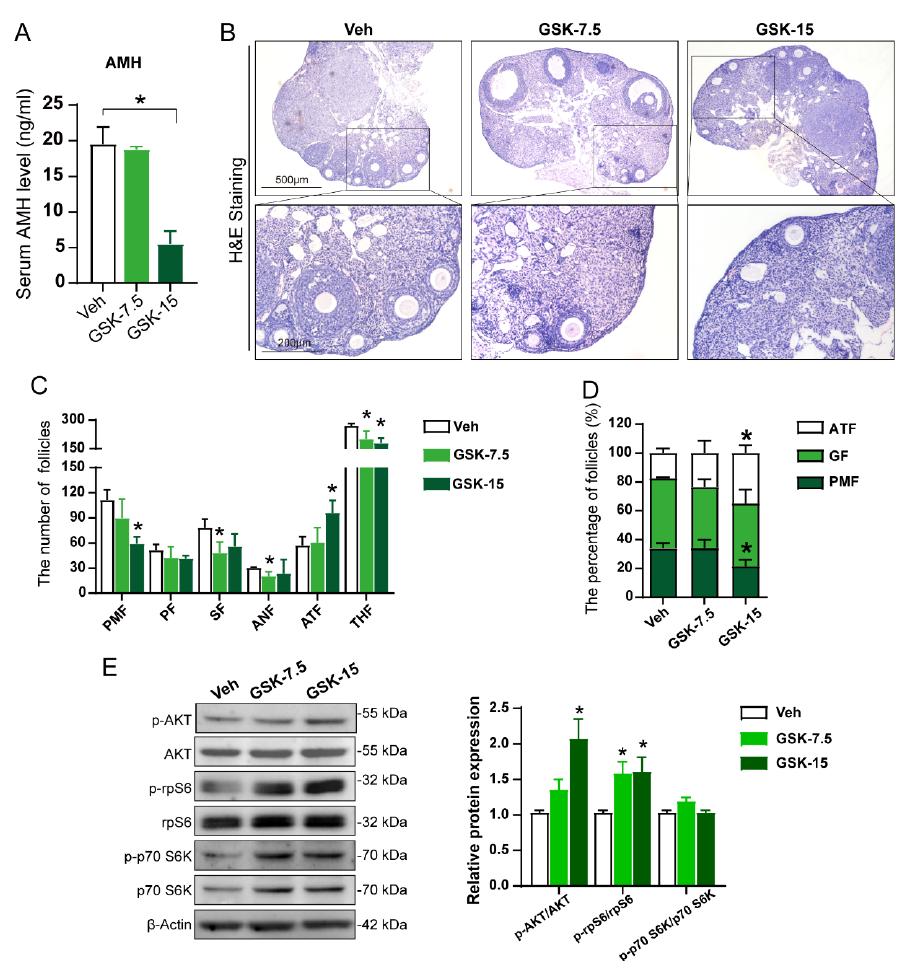
Figure 3. The WIP1 inhibitor treatment caused the decreased ovarian reserve in mice. ( A ) Serum AMH level ( n = 5, one-way ANOVA). ( B ) The representative H&E staining images of mouse ovaries. ( C ) Follicle counting results according to ovary serial sections ( n = 5, one-way ANOVA) (PMF: primordial follicles, PF: primary follicles, SF: secondary follicles, ANF: antral follicles, THF: total healthy follicles, ATF: atretic follicles). ( D ) The proportion of follicles at different stages ( n = 5, one- way ANOVA). ( E ) The primordial follicle-activation-related AKT-rpS6 signaling pathway proteins detected by Western blot ( n ≥ 3, one -way ANOVA). Data are presented as the mean ± SD. * compared with the Veh group. * p < 0.05.